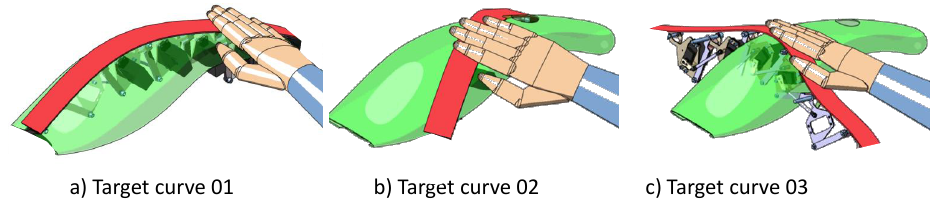
Figure 7. Different target curves during the curve